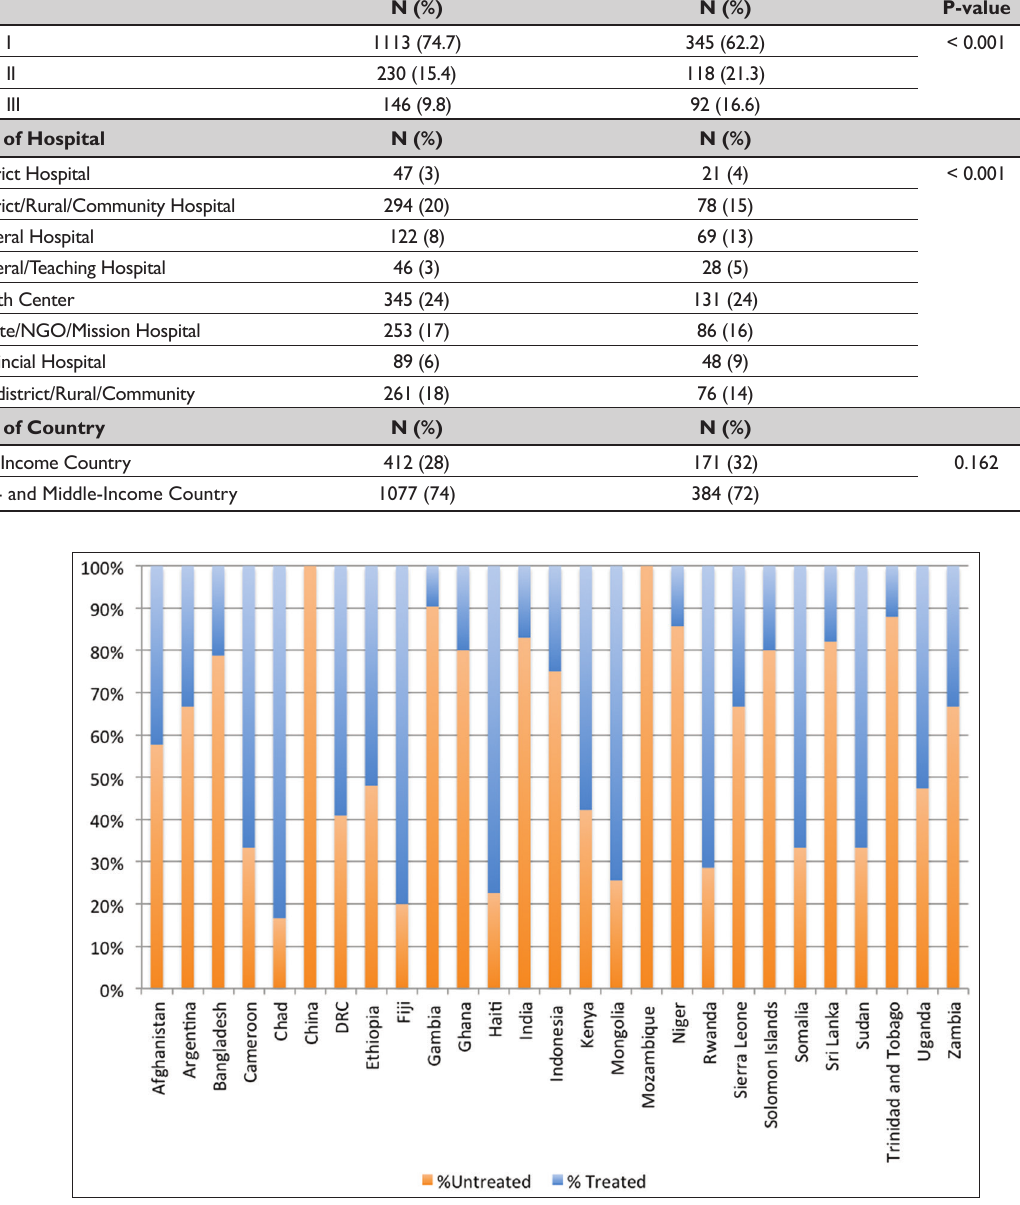
Figure 1: CTEV vs non-CTEV management by Country